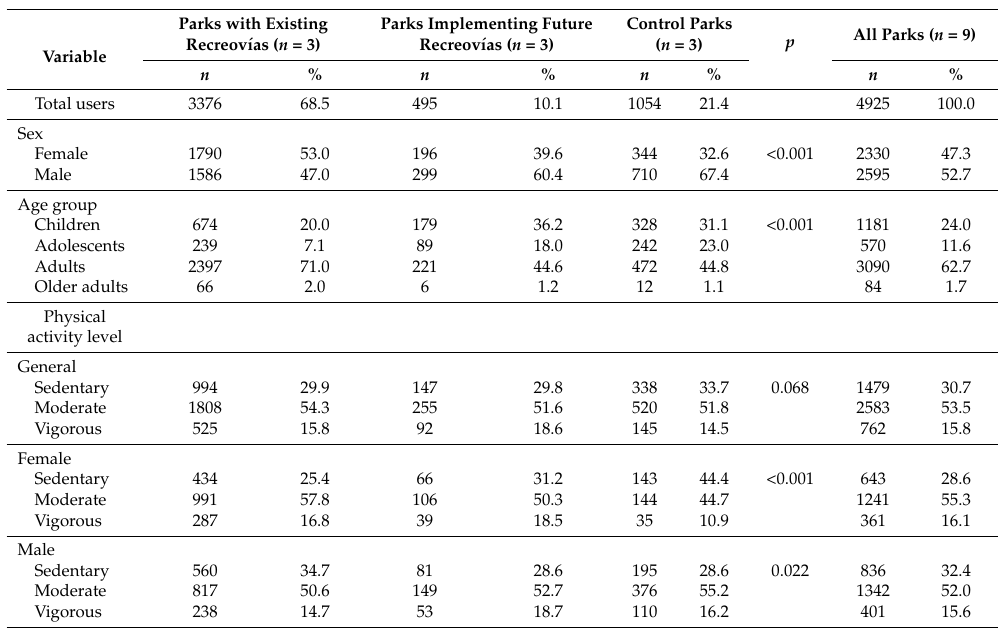
Table 3. Characteristics of park users by presence of the Recreov í a program in Bogot á , Colombia, 2013 ( n = 4925).